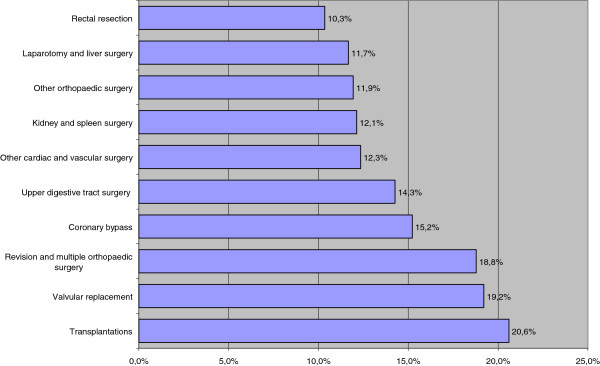
Rate of bleeding related consequences (Top 10 surgical groups).